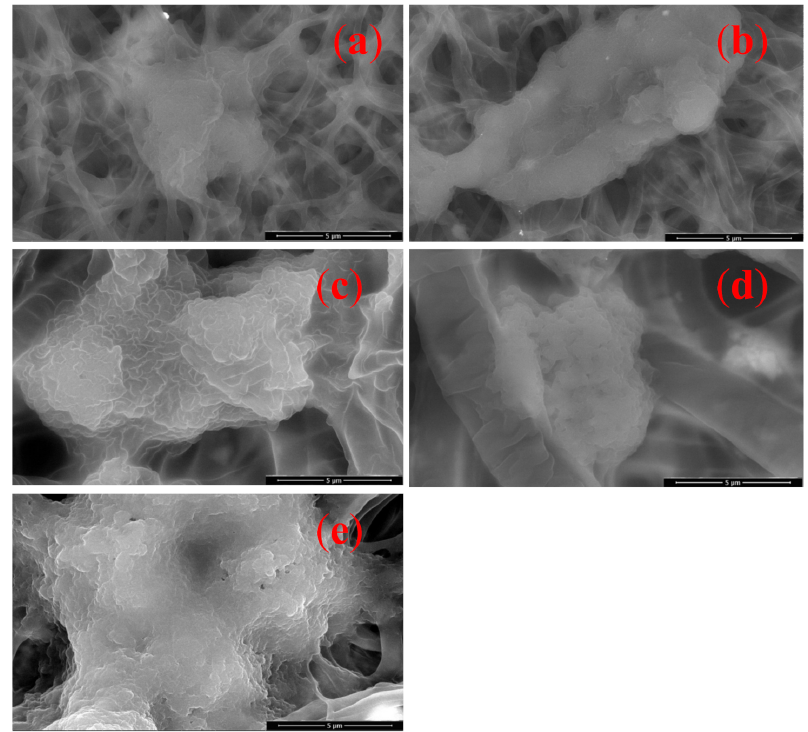
Figure 14. Cell growth of PCL nanofibrous scaffolds encapsulated with HAP co-doped with Ag/V after three days of cultivation media of human fibroblasts cell lines in vitro; ( a ) 0.0 Ag/V-HAP@PCL, ( b ) 0.2 Ag/V-HAP@PCL, ( c ) 0.4 Ag/V-HAP@PCL, ( d ) 0.6 Ag/V-HAP@PCL, ( e ) 0.8